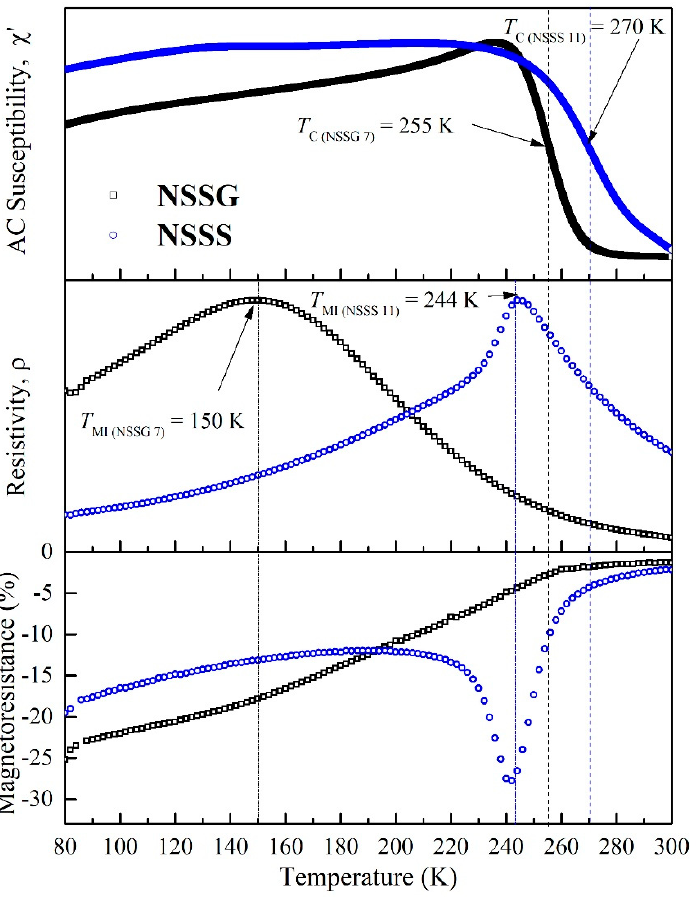
Figure 8. Relationship between χ ´, ρ , and MR as a function of temperature for NSSG and NSSS.